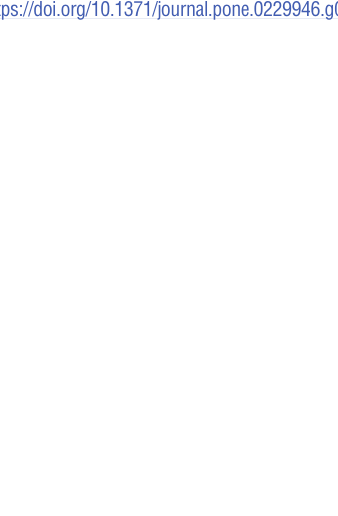
Fig 2. Geographical distribution of scaling tooth rate for persons with